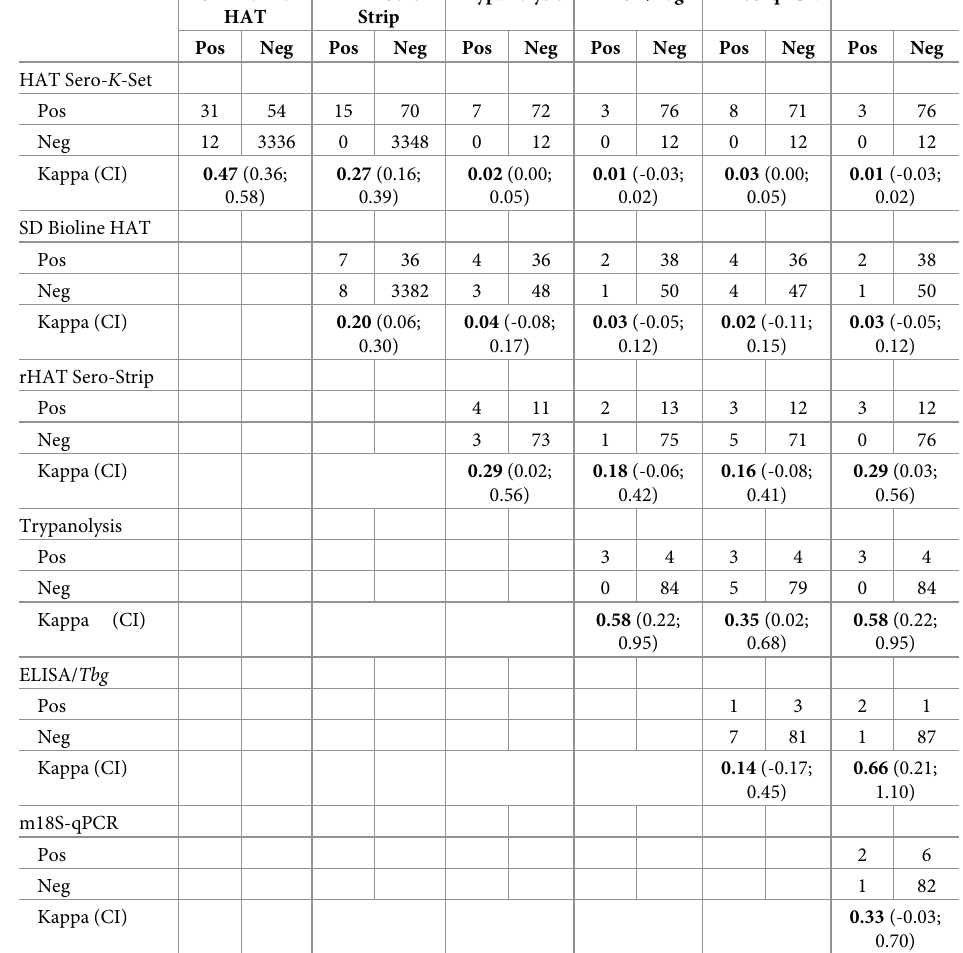
Kappa values are in bold, CI: confidence interval; Pos: positive; Neg: negative Table 5 details the agreement between tests. The kappa coefficient for the RDTs was calcu- lated on 3433 RDT results. Agreement between the 3 RDTs was moderate for each 2-way com- parison. Kappa coefficients were calculated between the laboratory tests and between laboratory and RDT results on the 91 available results. Agreement between the RDTs and the laboratory tests showed an overall poor agreement, except for trypanolysis and rHAT Sero- Strip which had moderate agreement (K = 0.3; CI 0.02–0.6). Laboratory tests showed moderate agreement, except for ELISA/ Tbg and LAMP tests which had a good level of agreement (K = 0.7; CI: 0.2–1.1).